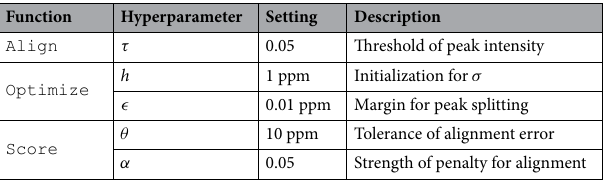
13 C NMR spectrum.